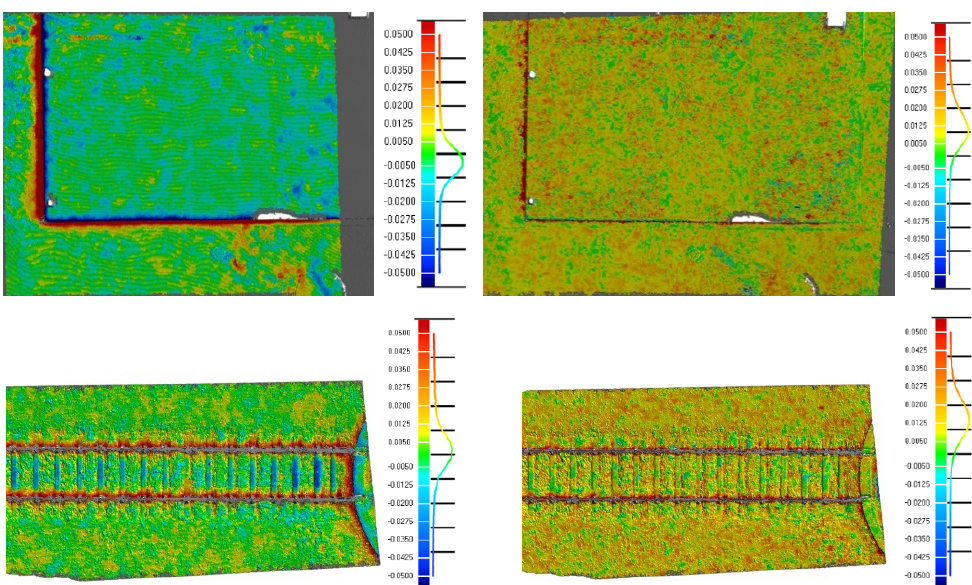
Figure 12. Vertical surface deviations of point clouds [m] compared to TLS reference data for the ramp (top) and the rails (bottom): PS TIF (left), Pix4D TIF (right)